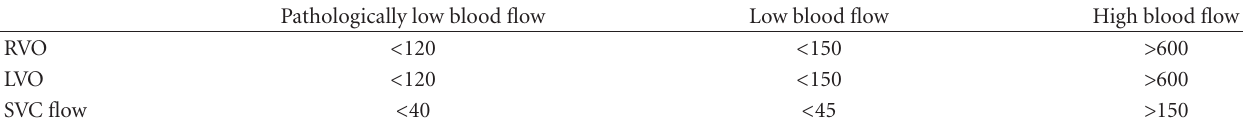
Table 7: Suggested cuto ff s for low and high central blood flow in preterm infants. Pathologically low blood